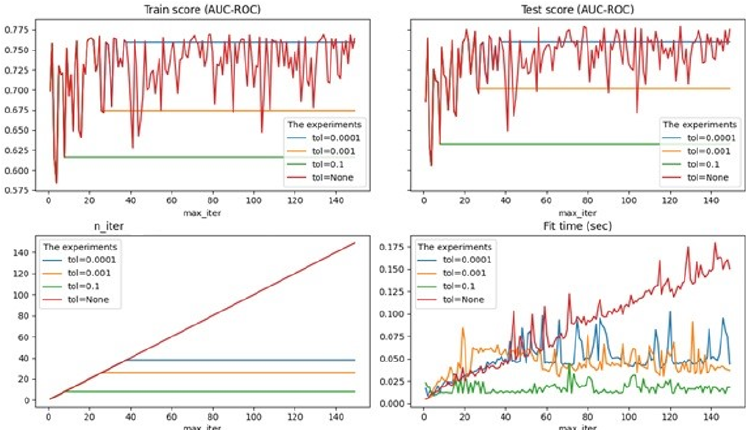
Figure 2. Results of experiments with the tol